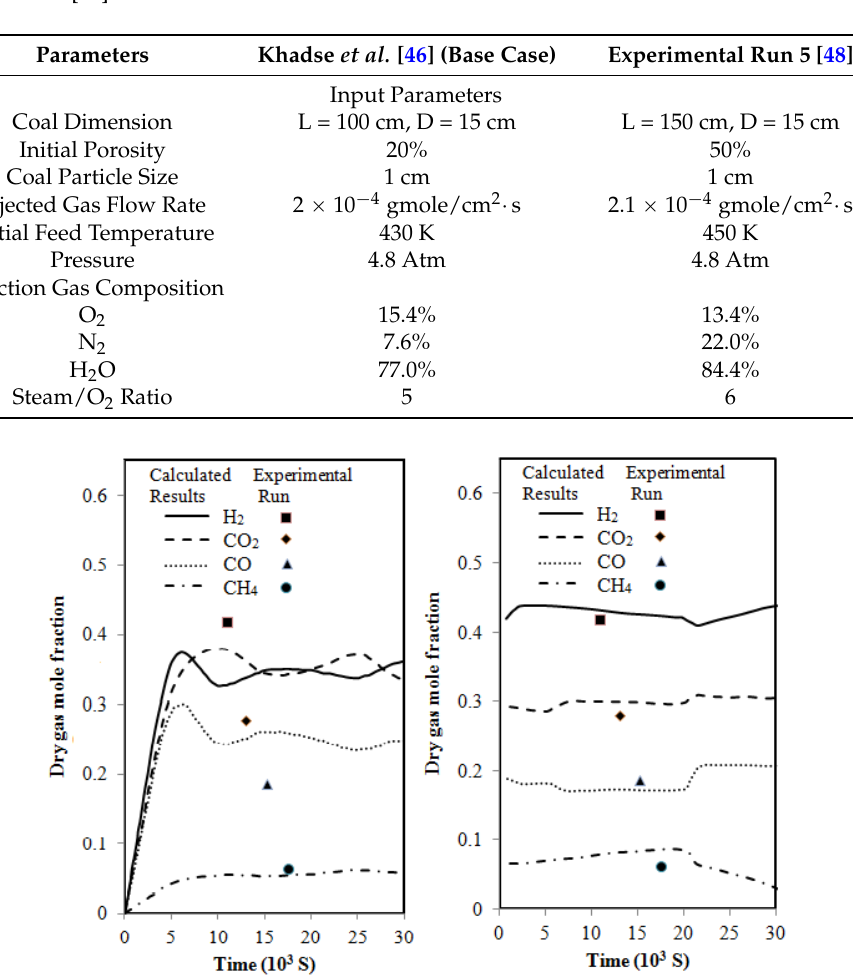
Table 8. Comparison of input parameters of Khadse et al. [46] with experimental run 5 of Thorsness et al. [48].